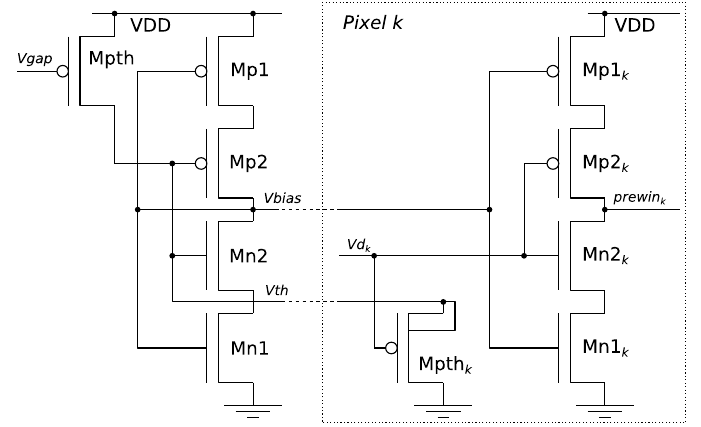
Figure 3. Adjustable comparator for winner identification.